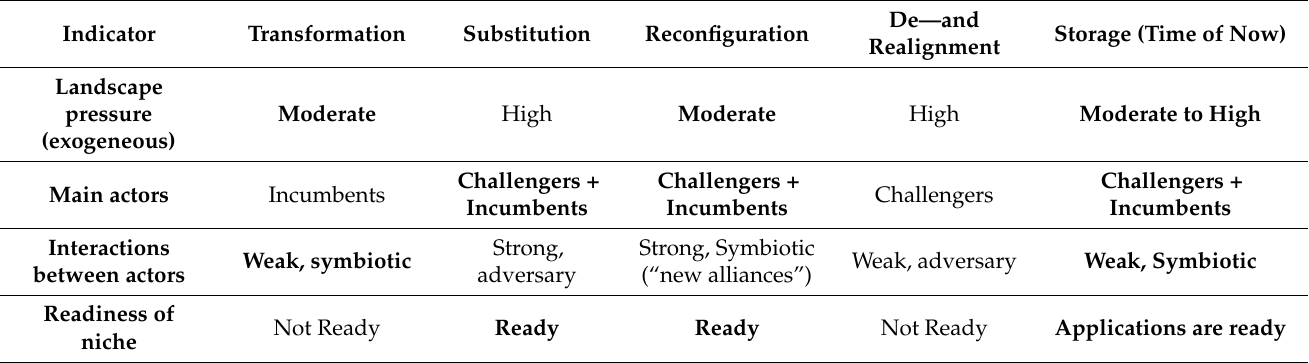
Table 3. Four possible transition pathways including their indicators to characterise each pathway with the indicators for the storage niche. Bold = actual situation for storage as of